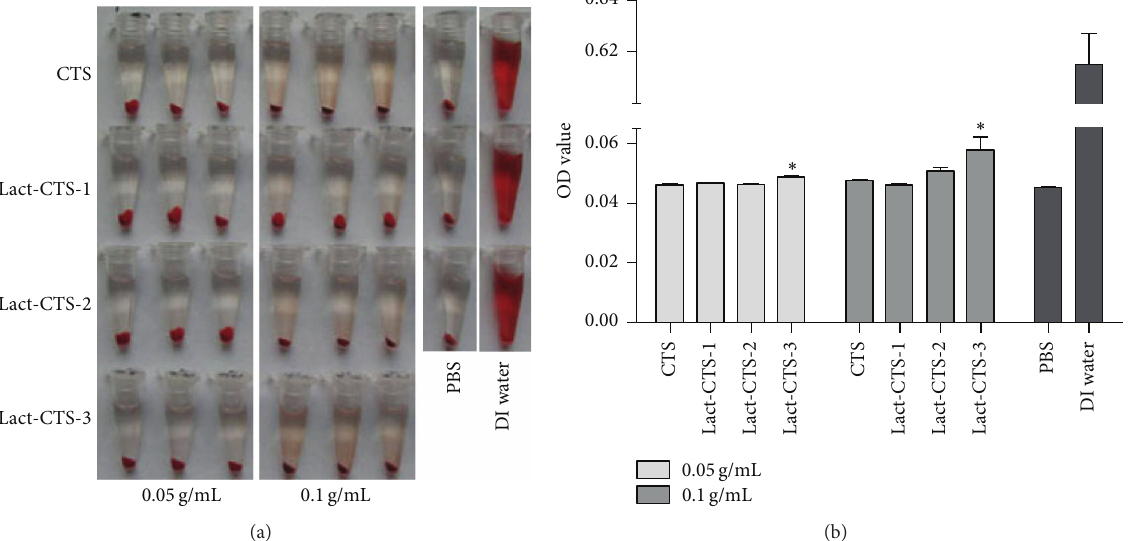
Figure 8: Hemolysis rate of RBCs treated with CTS, Lact-CTS-1, Lact-CTS-2, and Lact-CTS-3 scaffold extract solutions at concentration of 0.05 and 0.1 g/mL for 3 h. (a) Photographs of hemolysis. (b) Optical density of the supernatant, expressed as means ± SD from three independent experiments and then analyzed by one-way analysis of variance followed by Dunnett’s test for comparison against negative control. ∗ 𝑃 < 0.05 compared with negative control group. The presence of hemoglobin in the supernatant indicated damaged RBCs. PBS and DI water were used as the negative and positive controls,